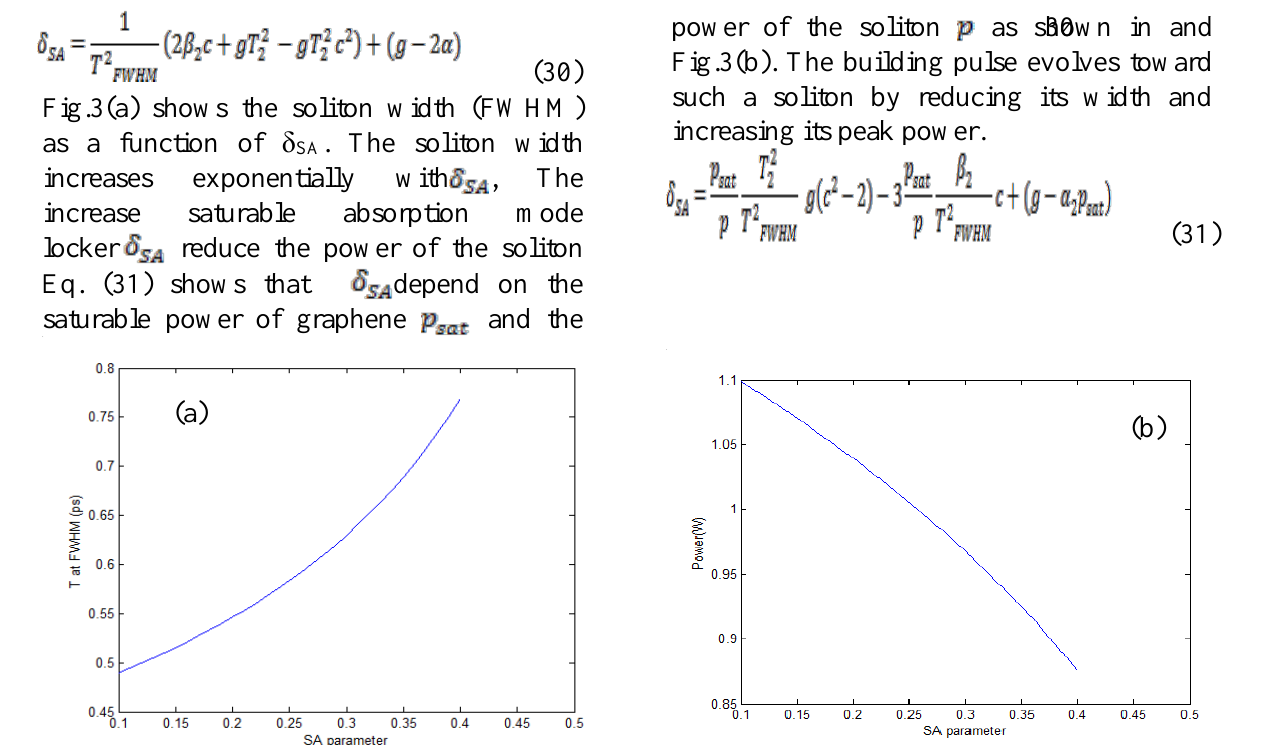
Fig.3(a): Output powers, (b)widths of soliton for different values